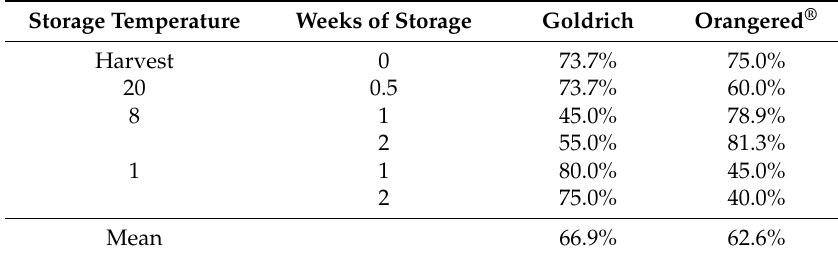
Table 1. Percentage of correctly classified ‘Goldrich’ and ‘Orangered ® ’ apricots according to storage temperature and duration obtained with discriminant analyses (DA) performed on 6 parameters